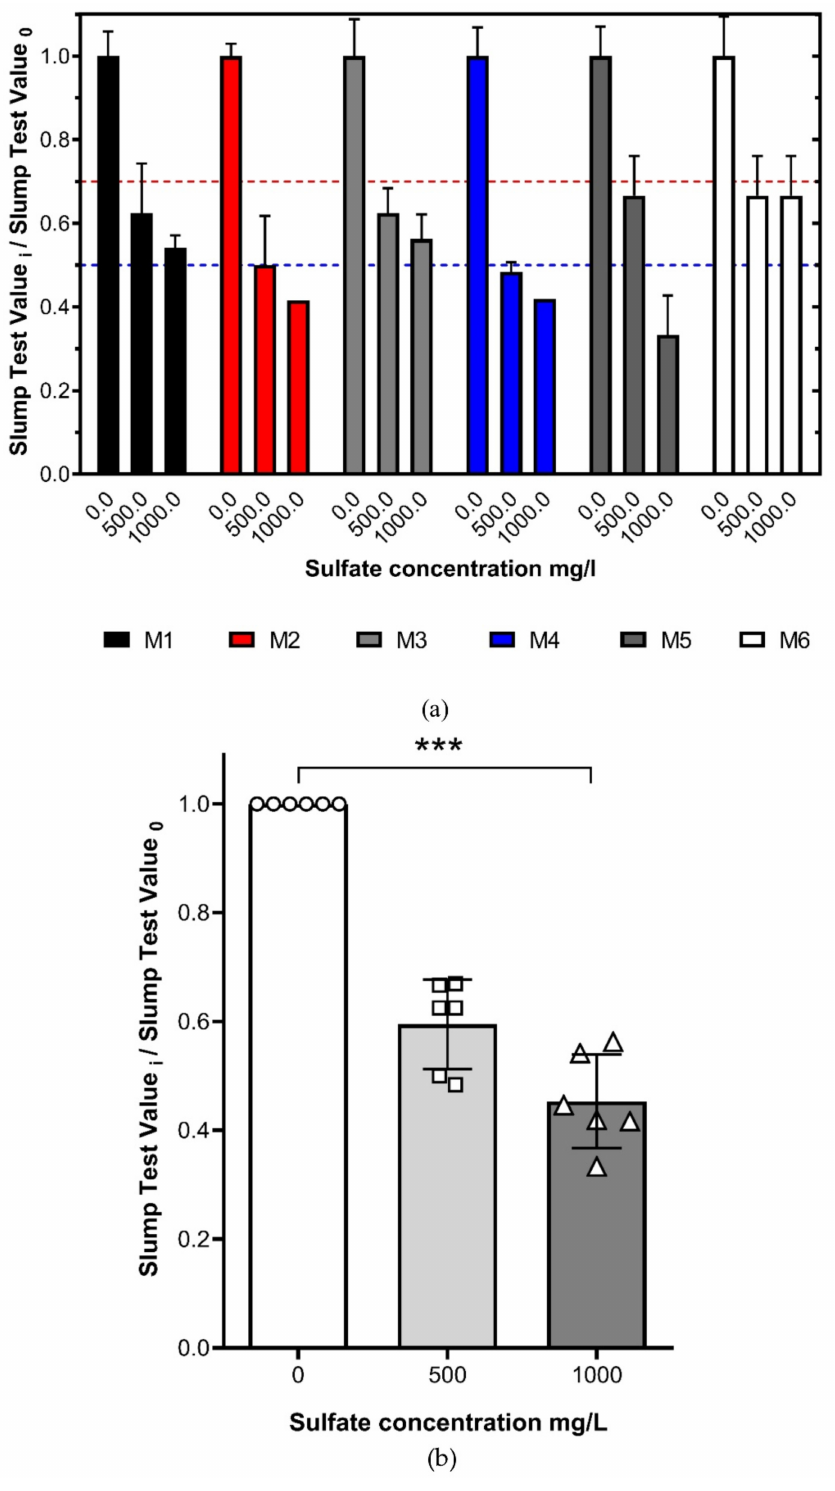
Figure 6. Effect of sulfate content on slump test values for individual ( a ) and grouped tailing samples ( a , b ). In ( b ), percentages of difference ( ∆ − 40% and ∆ − 55%) were calculated between the mean of the columns 500 and 1000 mg/L with the mean of slump test value at 0 sulfate